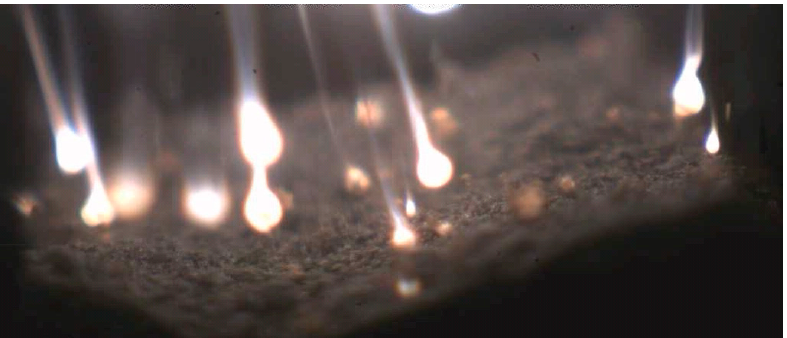
Figure 1. Burning surface of ammonium perchlorate propellant with incandescent aluminum ag- glomerates lofting from the surface.